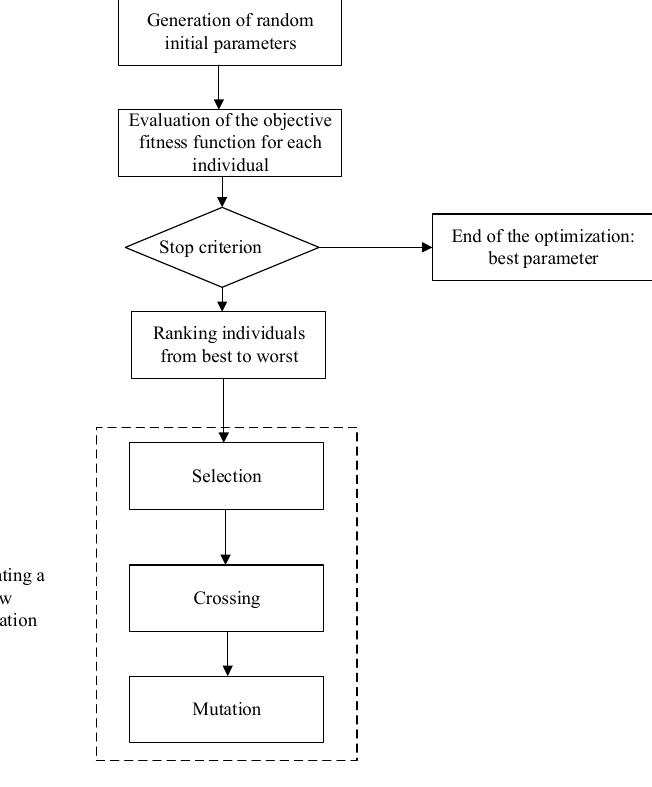
Figure 7. Flowchart of the GA for system loss optimized control.